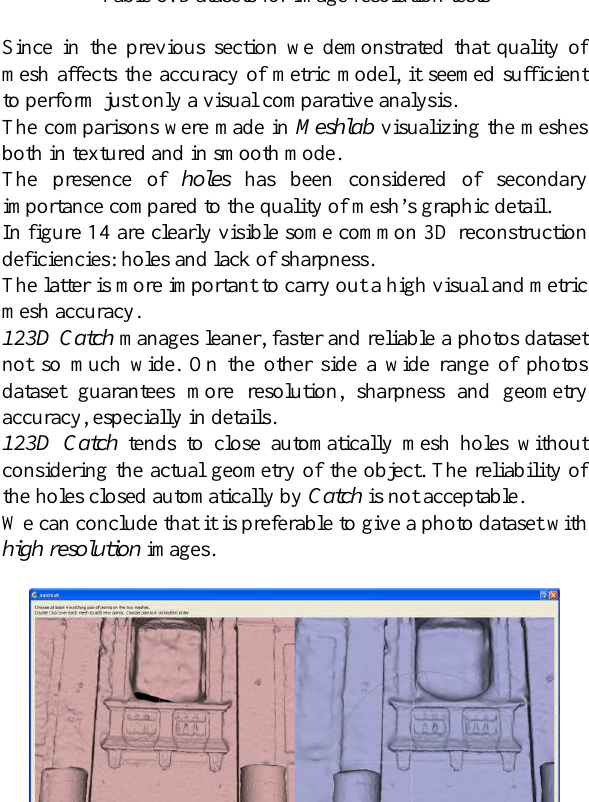
Table 5. Datasets for image resolution tests